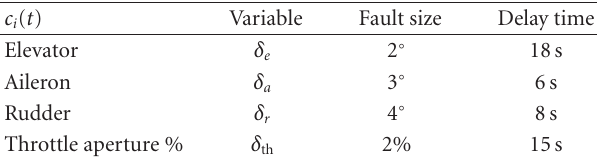
Table 2: PM FDI technique: minimal step faults with ν = 4.